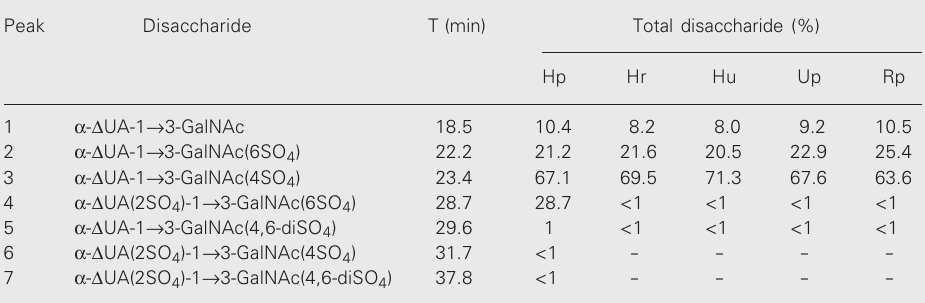
Table 1. Analysis of the disaccharides formed by chondroitinase ABC digestion of chondroitin sulfate from different regions of chicken wing cartilage. Peak